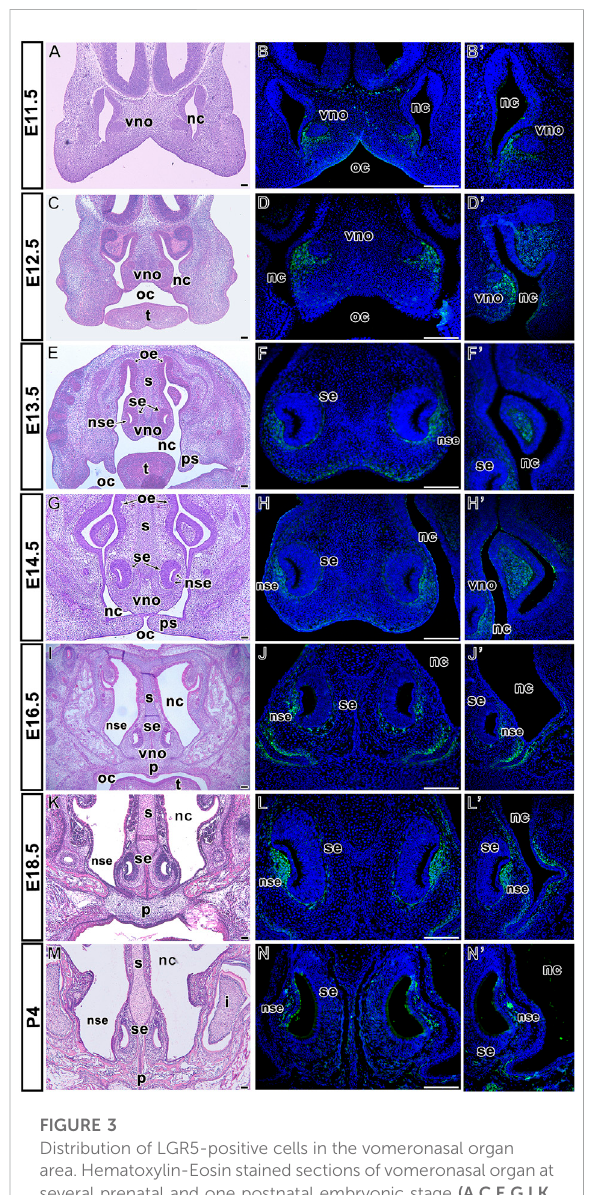
FIGURE 3 Distribution of LGR5-positive cells in the vomeronasal organ area. Hematoxylin-Eosin stained sections ofvomeronasal organ at several prenatal and one postnatal embryonic stage (A,C,E,G,I,K, M) . Expression of LGR5 is located in the mesenchyme underlyingthelateralepitheliumofthenasalcavityatE11.5 (B,B´ in detail ) and E12.5 (D) . LGR5-positive cells are observed in the mesenchyme of developing nasal conchae at E12.5 (D´) , E13.5 (F´) and E14.5 (H´) . Signal of LGR5-positive cells is also situated in the mesenchymeofbothsensoryandnon-sensoryepitheliumofVNO at E13.5 (F) and E14.5 (H) . At the next stages, LGR5-positive cells arelocatedinthemesenchymeofnon-sensoryepitheliumofVNO atE16.5 (J) ,E18.5 (L) orP4 (N) ,aswellasinthelateralmesenchyme surrounding the nasal cavity, and in the mesenchyme surrounding ventral epithelium of the nasal cavity at E16.5 (J´) , E18.5 (L´) and P4 (N´) . i, incisor; nc, nasal cavity; ns, nasal septum; nse, non- sensory epithelium; oe, oral epithelium; oc, oral cavity; p, palate; ps, palatal shelves; se, sensory epithelium; t, tongue; vno, vomeronasal organ. Scale bars = 100 μ m.